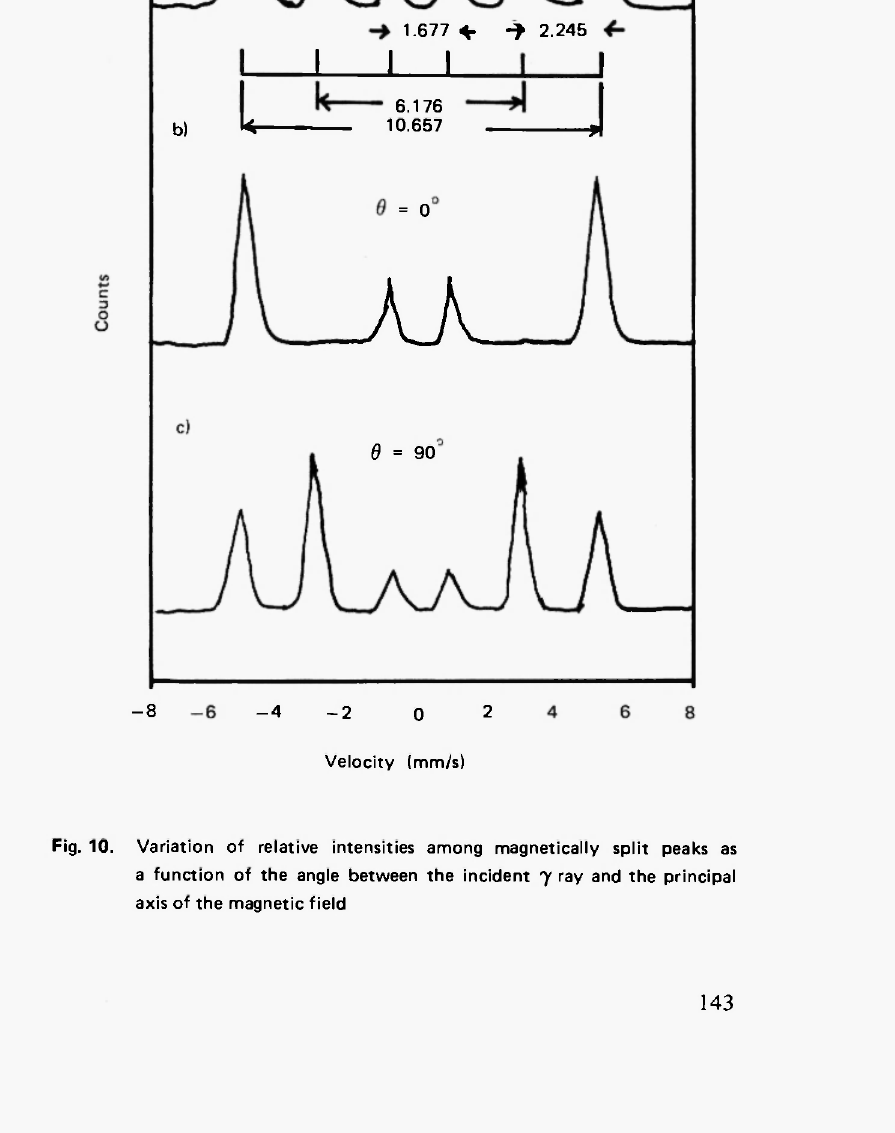
Fig. 10. Variation of relative intensities among magnetically split peaks as a function of the angle between the incident γ ray and the principal axis of the magnetic